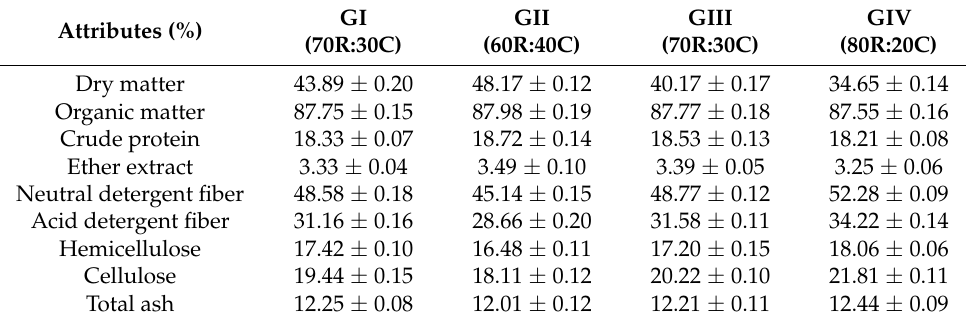
Table 2. Chemical composition (%) of TMR in different groups of goats: GI (control), GII (60R:40C with 10% of concentrate replaced with ML), GIII (70R:30C and 20% replacement of concentrate with ML), and GIV (80R:20C and 20% replacement of concentrate with